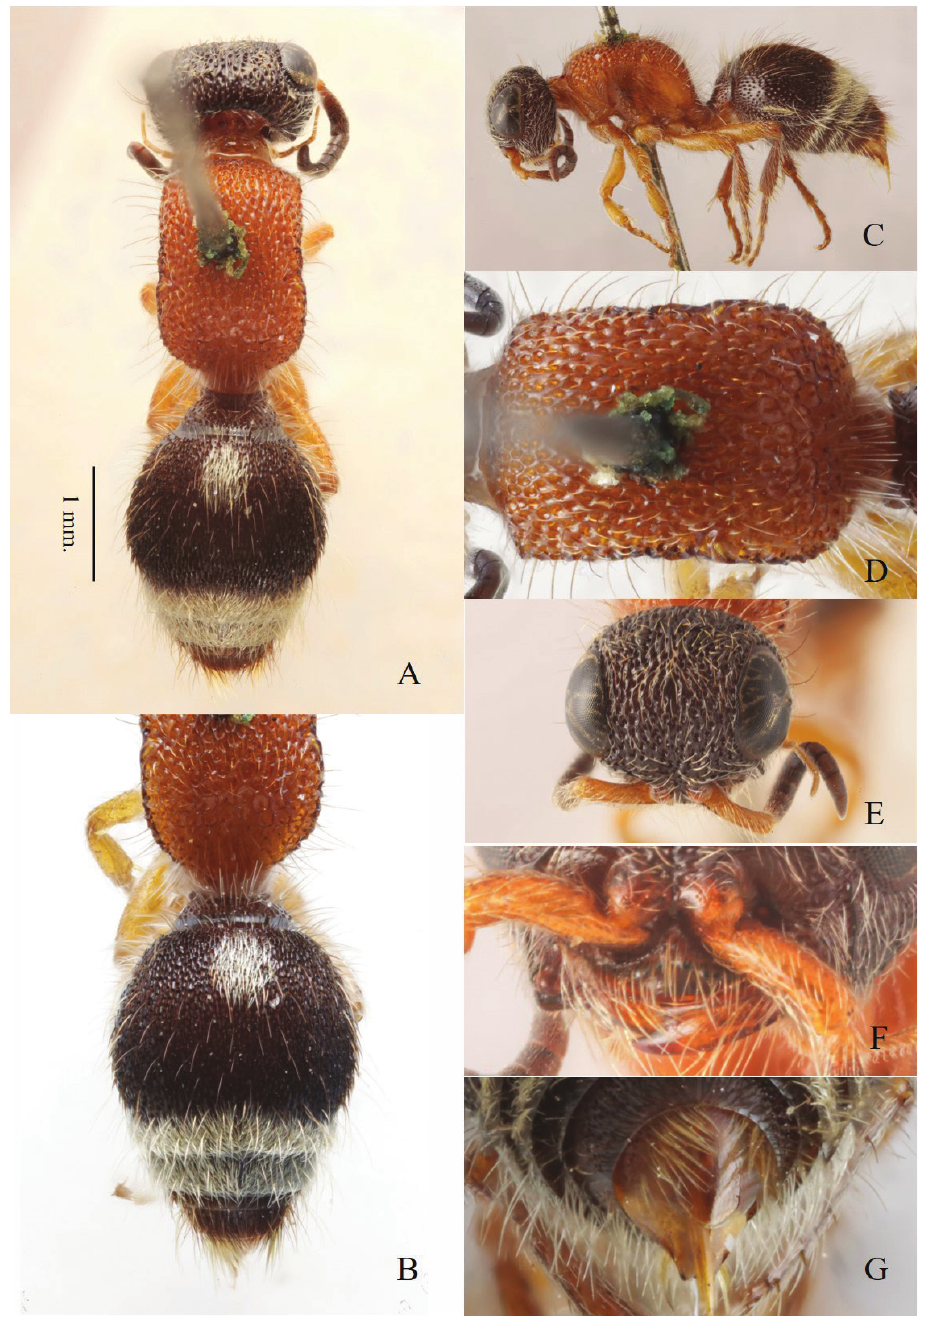
Figure 4. Nordeniella dokbua sp.nov., holotype, female A dorsal view B posterior propodeal face and metasoma dorsum C lateral view D mesosoma E frons and vertex F clypeus G